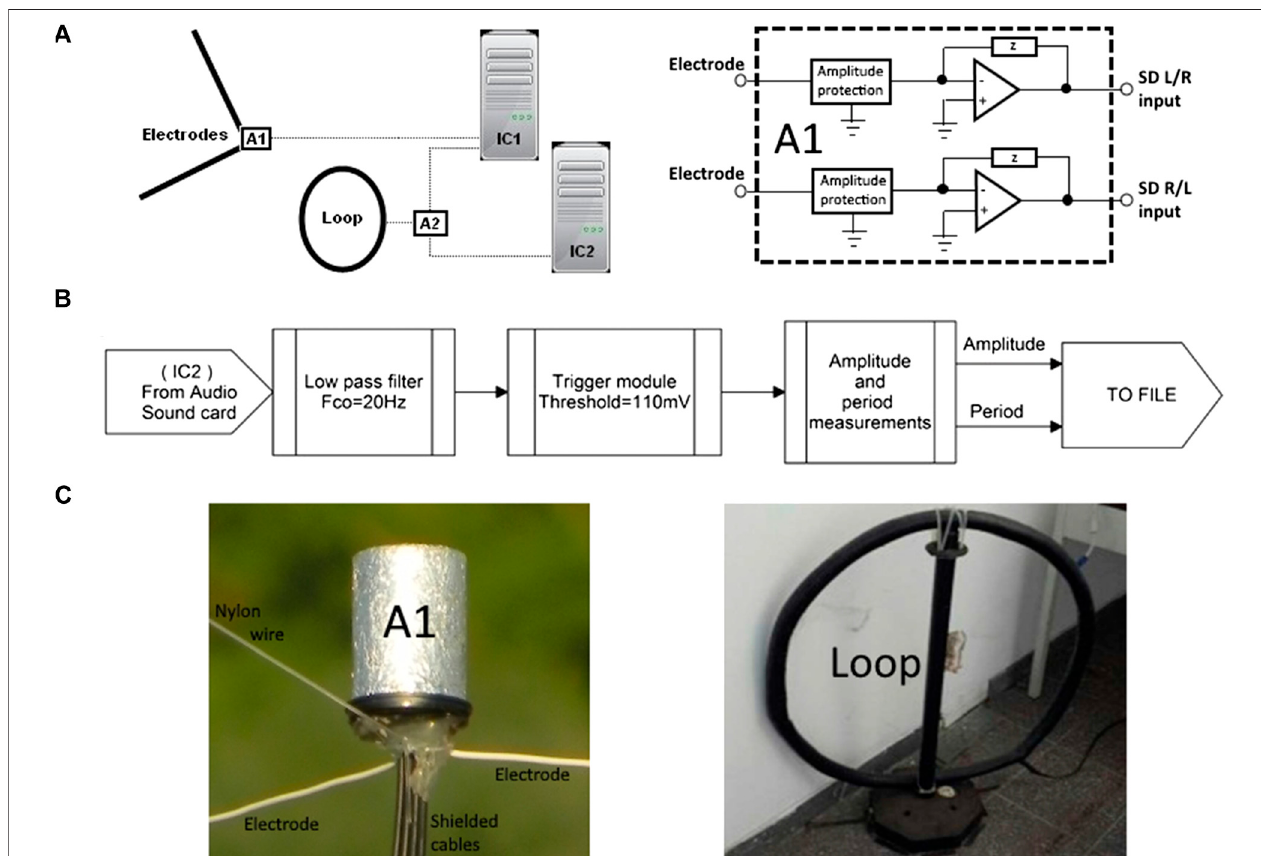
FIGURE2|A) Con fi gurationoftheconnectionsoftheelectrodesandtheloopantennathroughtheampli fi ersA1andA2atcomputersIC1andIC2,ontheleft,and thebasicschemeofA1ontheright. (B) Simpli fi edblockdiagramofthelaboratoryviewdataacquisitionsoftwareatIC2only,consistingofthreemainblocksstartingfrom the fi rst low-pass fi lter; the second block is the voltage threshold discriminator, the next block measure the amplitude and the period of the signals. (C) The electric detector made up of electrodes converging in the A1 double ampli fi er box in the photo on the left, and a particular of the loop in the photo on the